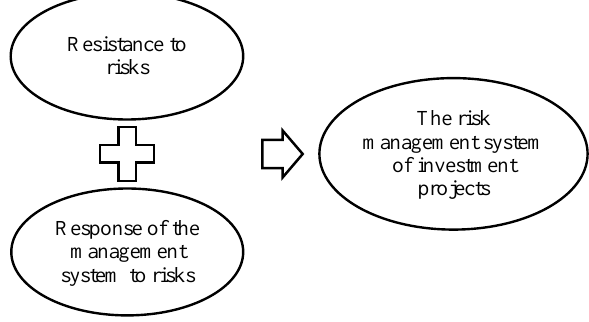
Figure 7. The scheme of components of risk resilience in the risk management system of investment projects.